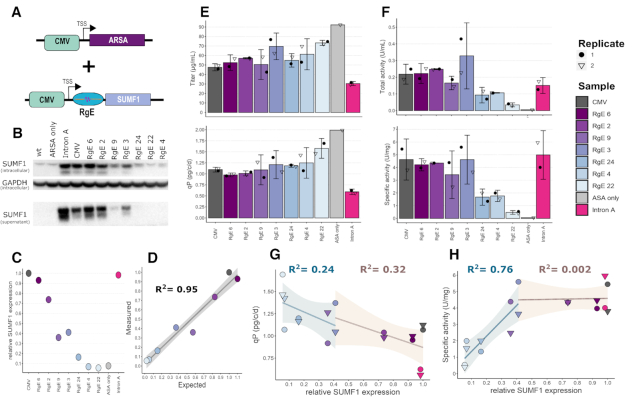
Tuning of helper protein SUMF1 levels impact ASA expression and activity. (A) Schematic overview of the expression strategy. (B) Western blot detection of SUMF1 levels intracellularly (from cell lysates) and secreted (supernatant). GAPDH was used as loading control. (C) Calculated relative SUMF1 expression levels (to CMV sample) based on intracellular and secreted SUMF1 signals form (B). (D) Measured and calculated SUMF1 levels based on the western blot versus the expected levels from Figure 2C. Gray area shows standard error. (E) Measured ASA titer (top) and calculated qP (bottom) values (n = 2 independent samples). Error bars show 95% confidence interval. (F) Measured ASA activity (top) and calculated protein specific activity (bottom) (n = 2 independent samples). Error bars as in (E). (G) ASA qP versus relative SUMF1 expression. R2 calculated by linear regression of low (blue) and high (brown) relative SUMF1 expressions. Colored areas show standard error. (H) ASA specific activity versus relative SUMF1 expression.